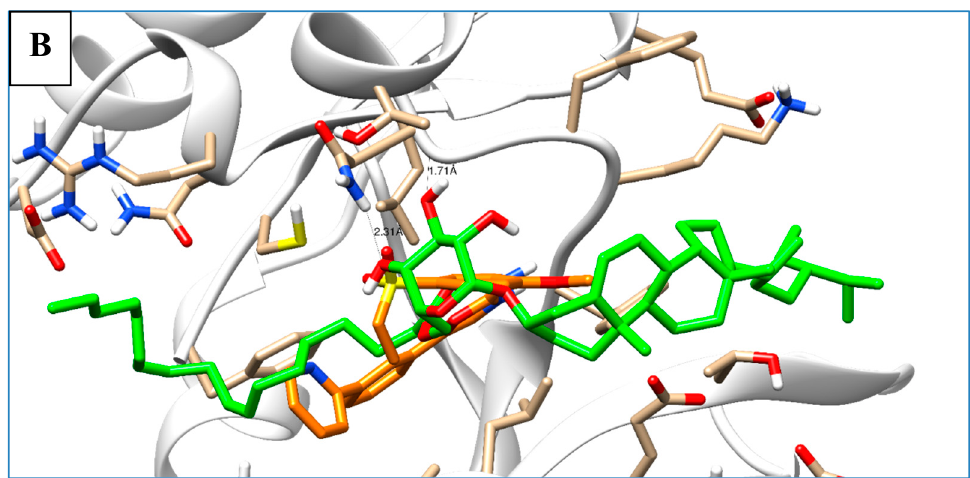
Figure 7. Superimposition of compound 1 (green) and the co-crystallized ligand (orange) inside both receptor-binding sites of the ( A ) tyrosine-specific protein kinase (TPK) (1T46) and ( B ) vascular endothelial growth factor receptor (VEGFR-2) (1Y6A).